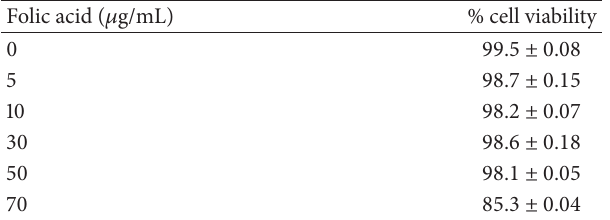
Table 2: Effects of folic acid on cell viability, examined using the MTT test. BV-2 microglial cells were treated with various concentrations of folic acid (FA) (5, 10, 30, 50, and 70 𝜇 g/mL) for 24 h. Experimental treatments were analyzed in triplicate and data are expressed as the mean ± SD of five independent